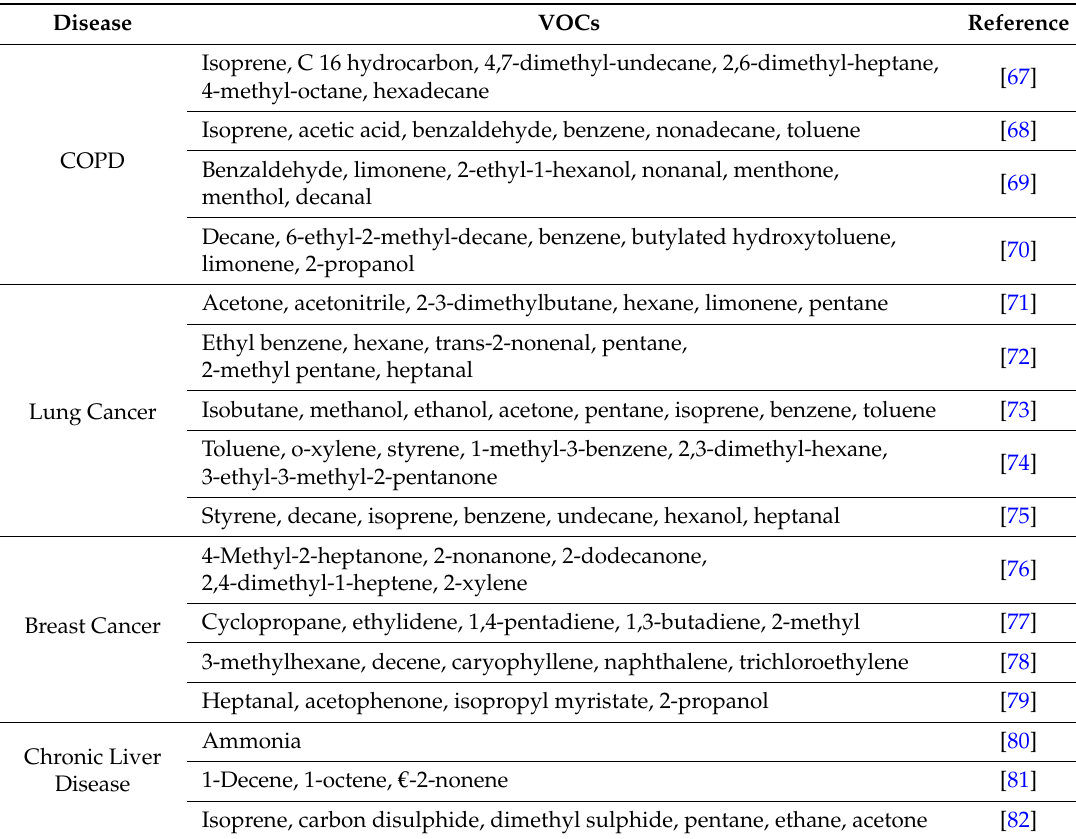
Table 3. List of diseases and the VOCs found in relation to each.